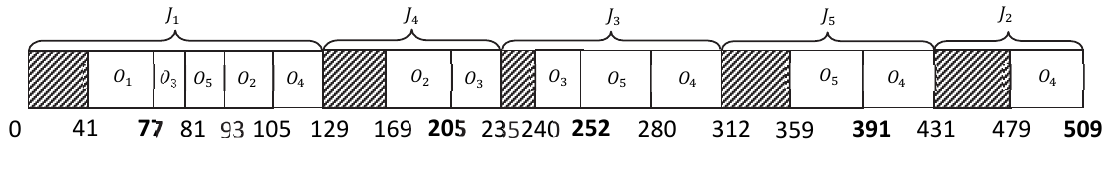
Fig. A.1. Gantt chart of the schedule for the numerical example